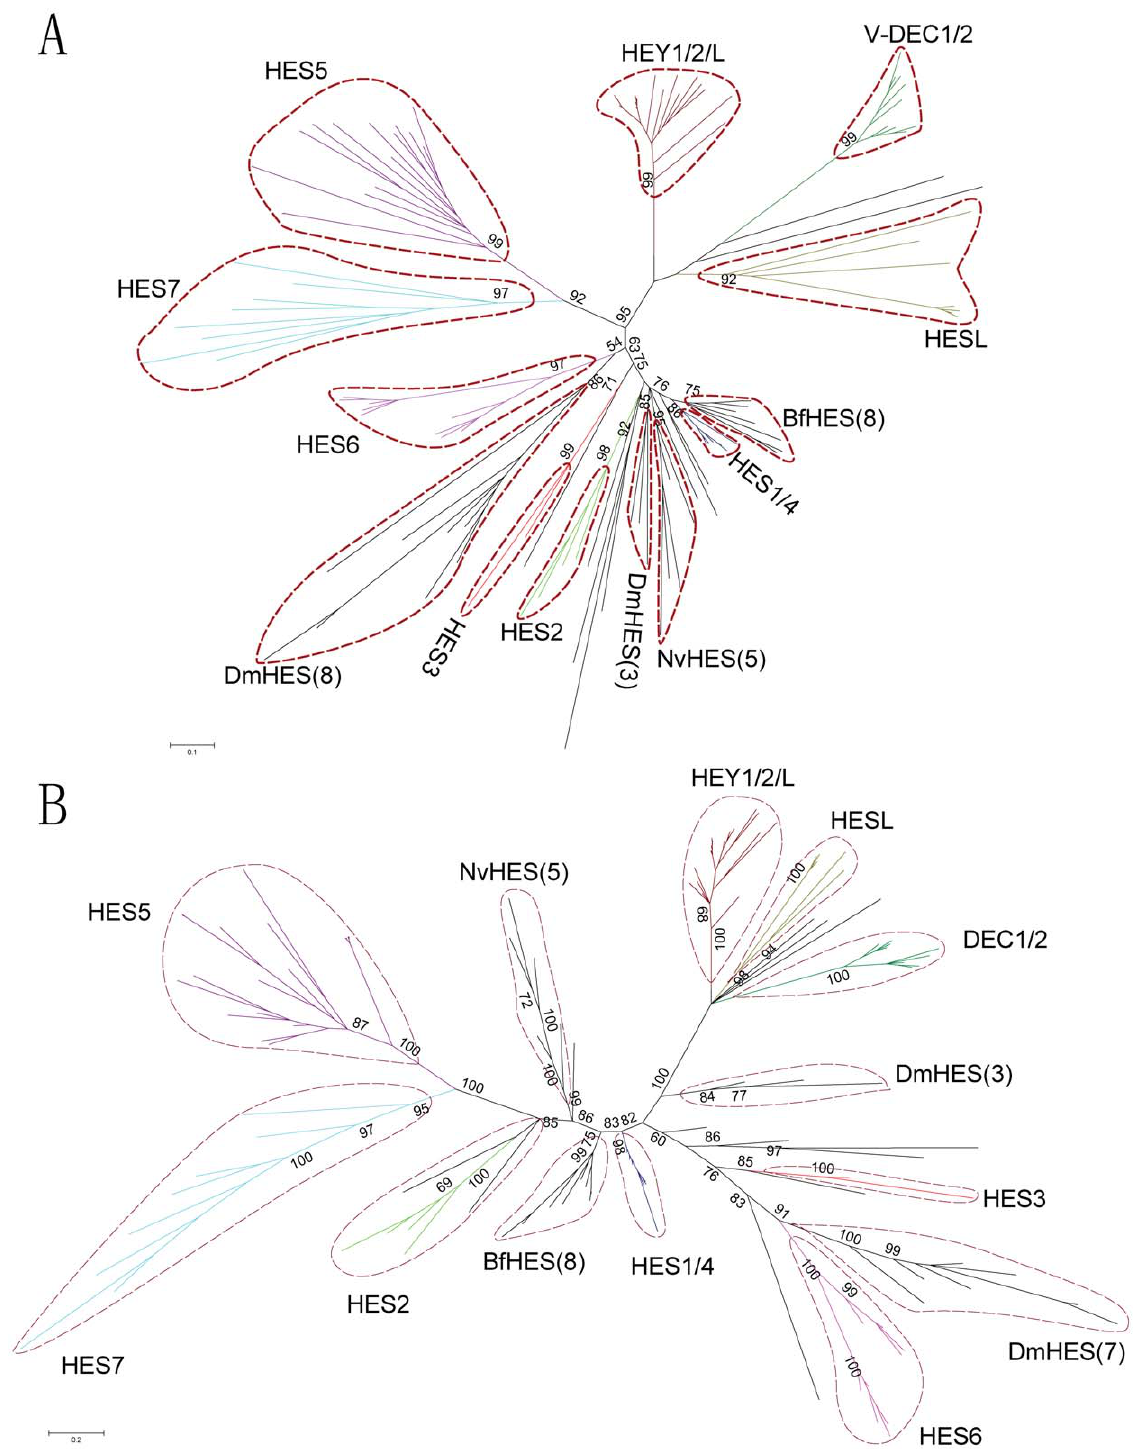
Figure 2. Unrooted Neighbor-Joining and Bayesian phylogenetic tree of HES/HEY genes. The trees were inferred by the Neighbor-Joining (NJ) with JTT model (A) and Bayesian (B) based on amino acid sequences of the bHLH and Orange domains. Colors denote different subgroups of HES/HEY, crimson: HEY1/2/L, dark green: V-DEC1/2, deep yellow: HESL, cyaneous: HES1/4, red: HES3, pink: HES6, prasinous: HES2, light blue: HES7, purple: HES5. Some species specific HES clusters including NvHES, DmHES, and BfHES were in black. Numbers in brackets refer to the numbers of the sequences in these species specific clusters. Nv, Dm and Bf are the abbreviations of Nematostella vectensis, Drosophila melanogaster and Branchiostoma floridae.